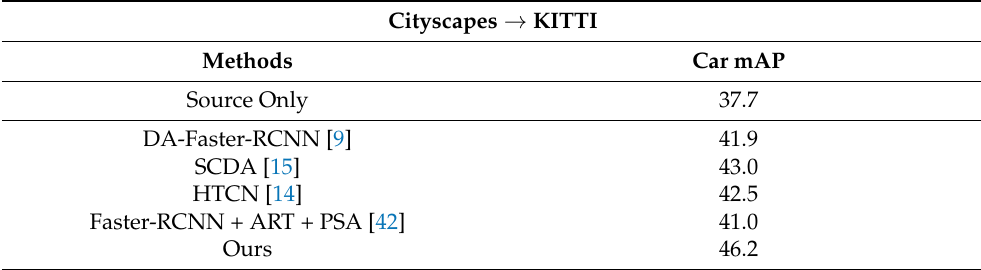
Table 2. Camera angle adaptation: results on adaptation from Cityscapes to KITTI.